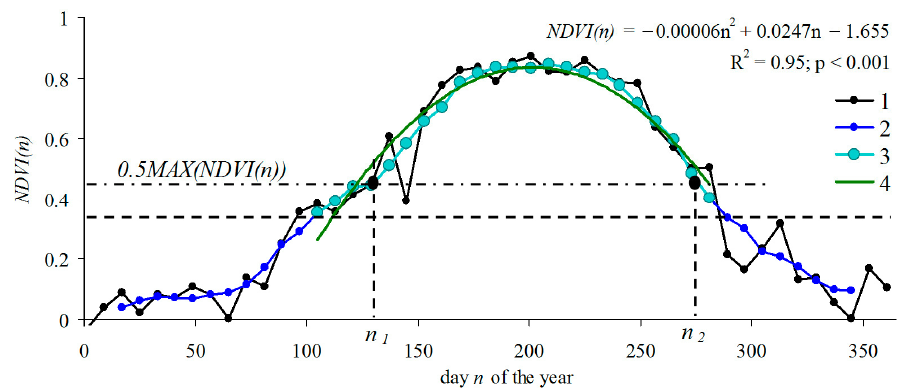
Figure 4. A typical Normalized Difference Vegetation Index (NDVI)( n ) time series, sample plot No. 2 (2014) and processing procedure. 1–a series of 8-day NDVI time composites; 2–a filtered NDVI time series; 3–series 2 clipped at critical values NDVIcrit = 0.35(NDVImax–NDVImin); 4–parabolic approximation of NDVI series; n 1 , n 2 -dates of the beginning and end of the growing season, when NDVI( n ) > 0.5 NDVImax( n ).